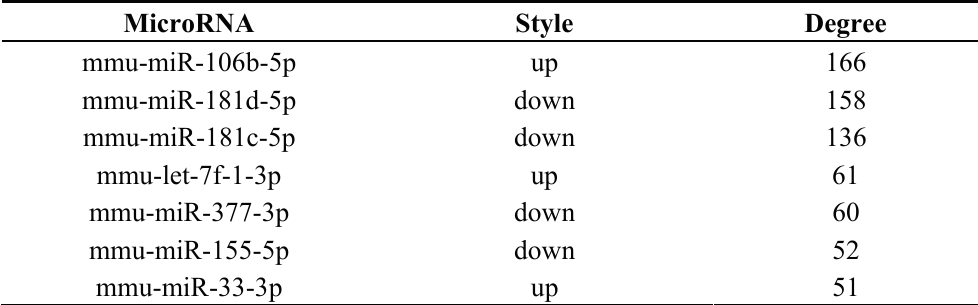
Table 1. The miRNAs regulated genes with degrees above